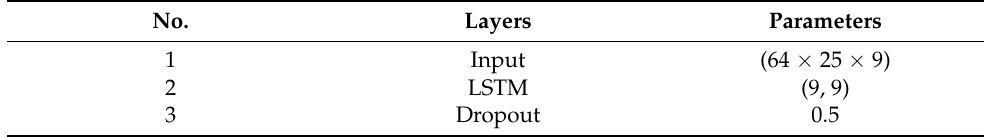
Table 2. Structure of LSTM prediction